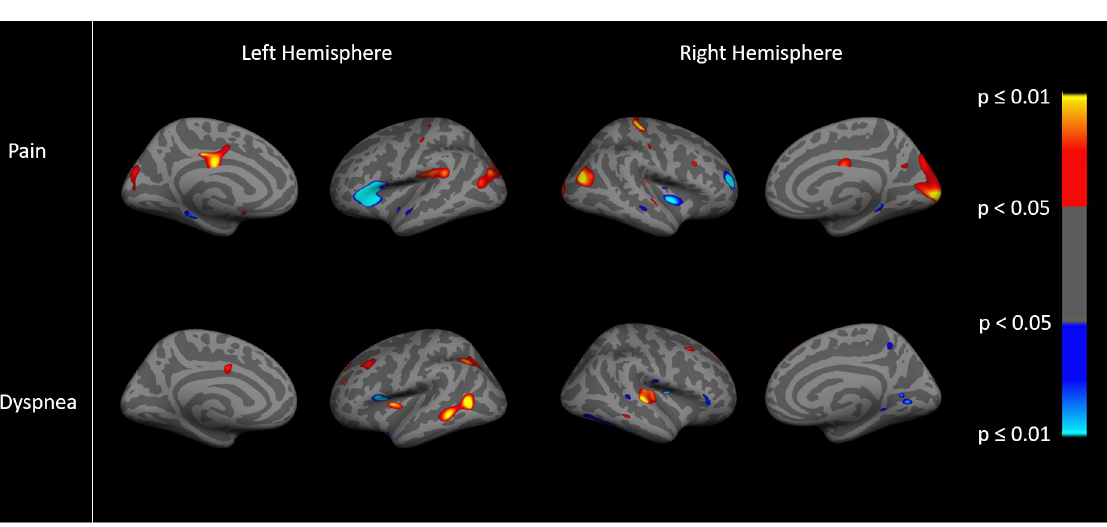
Fig 2. Associations between DMN functional connectivity with pain (top) and dyspnea (bottom).